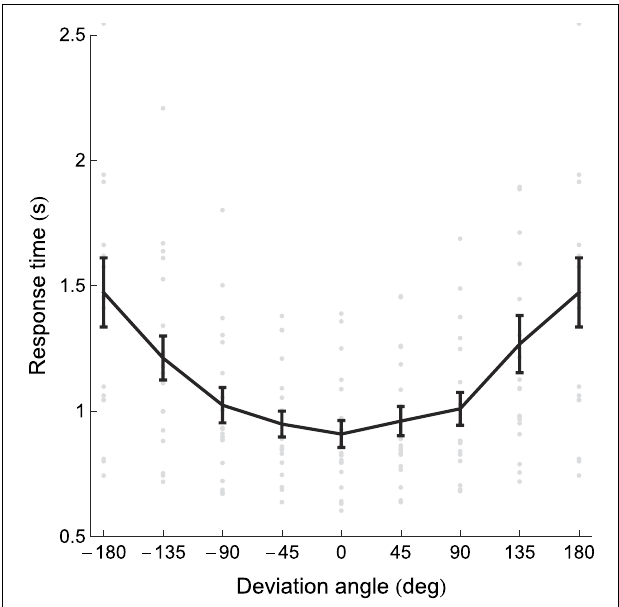
FIGURE 5 | Response times and error rates increase with absolute deviation angle. Gray dots represent individual participants’ data, the black curve the mean, and error bars between-subject SE.The data for deviation angles ± 180˚ is shown twice. Several outlying datapoints are not shown. Figure 5 shows the error rates as a function of the deviation